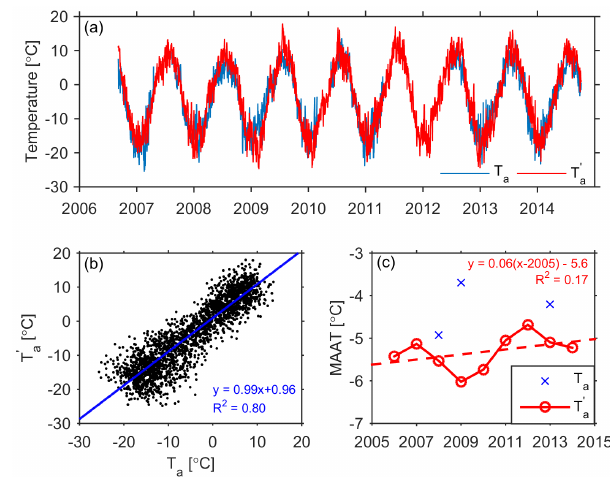
Figure 7. Air temperature change over the period of 2006–2014. (a) Comparison of observed and projected daily averaged air tem- perature ( T a and T (cid:48) a ). (b) Relationship between T a and T (cid:48) a with a lin- ear regression. (c) Comparison of the observed and projected annual mean air temperature (MAAT) after correction with (b) . A linear- fitted (dashed line) warming rate of 0.07 ◦ Cyr − 1 is derived from the projected